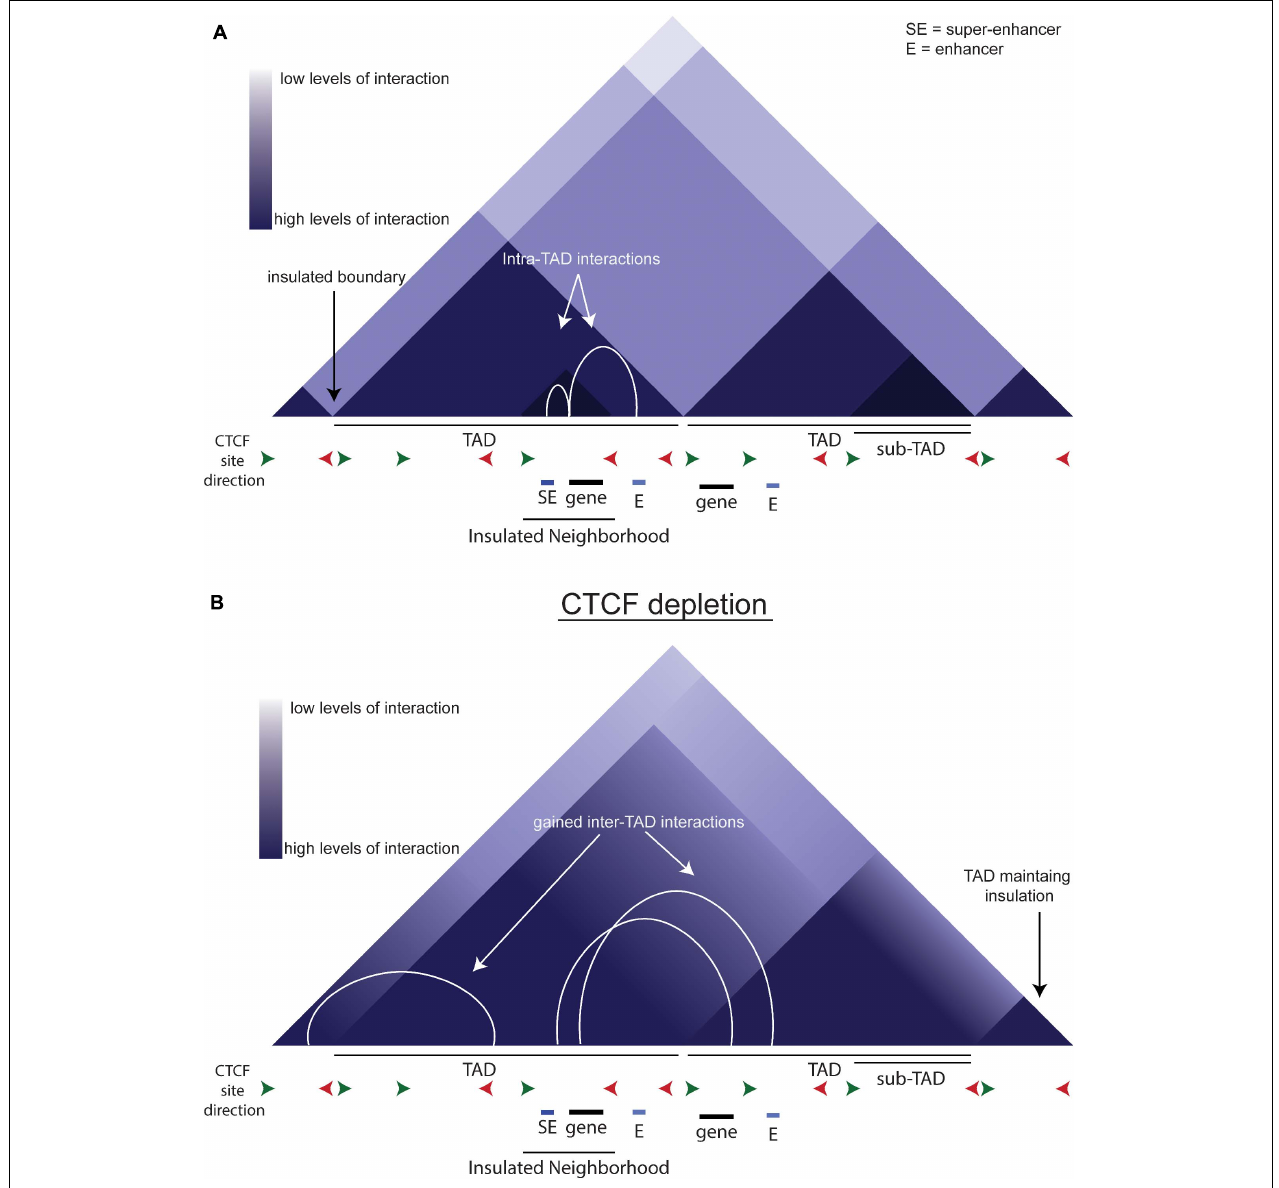
FIGURE 2 | TADs and CTCF. (A) Schematic of chromatin organization. The triangles depict a schematic of a Hi-C contact map. White arcs show the intra-TAD interactions that are insulated by CTCF. (B) Schematic of what a Hi-C contact map may look like upon CTCF depletion. White arcs show the gained interactions across previous TAD